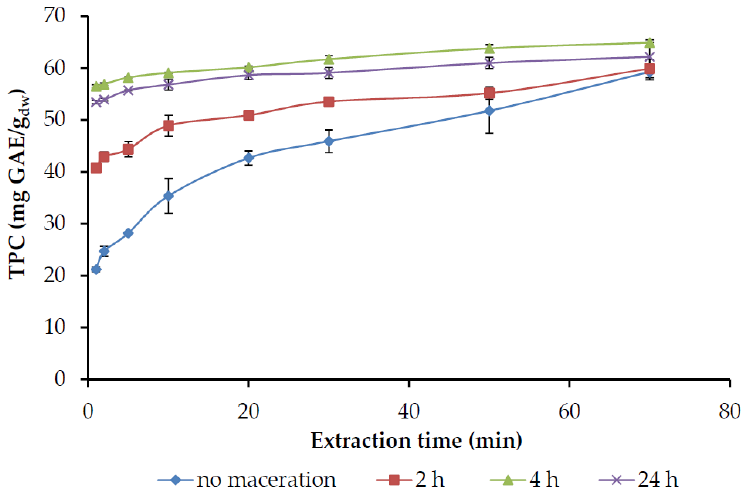
Figure 9. The influence of maceration time of ground rosemary leaves in cold water, on total phenols recovery (TPC), through extraction by ethanol 60%, at a solid-to-liquid ratio of 1:20 g/mL.